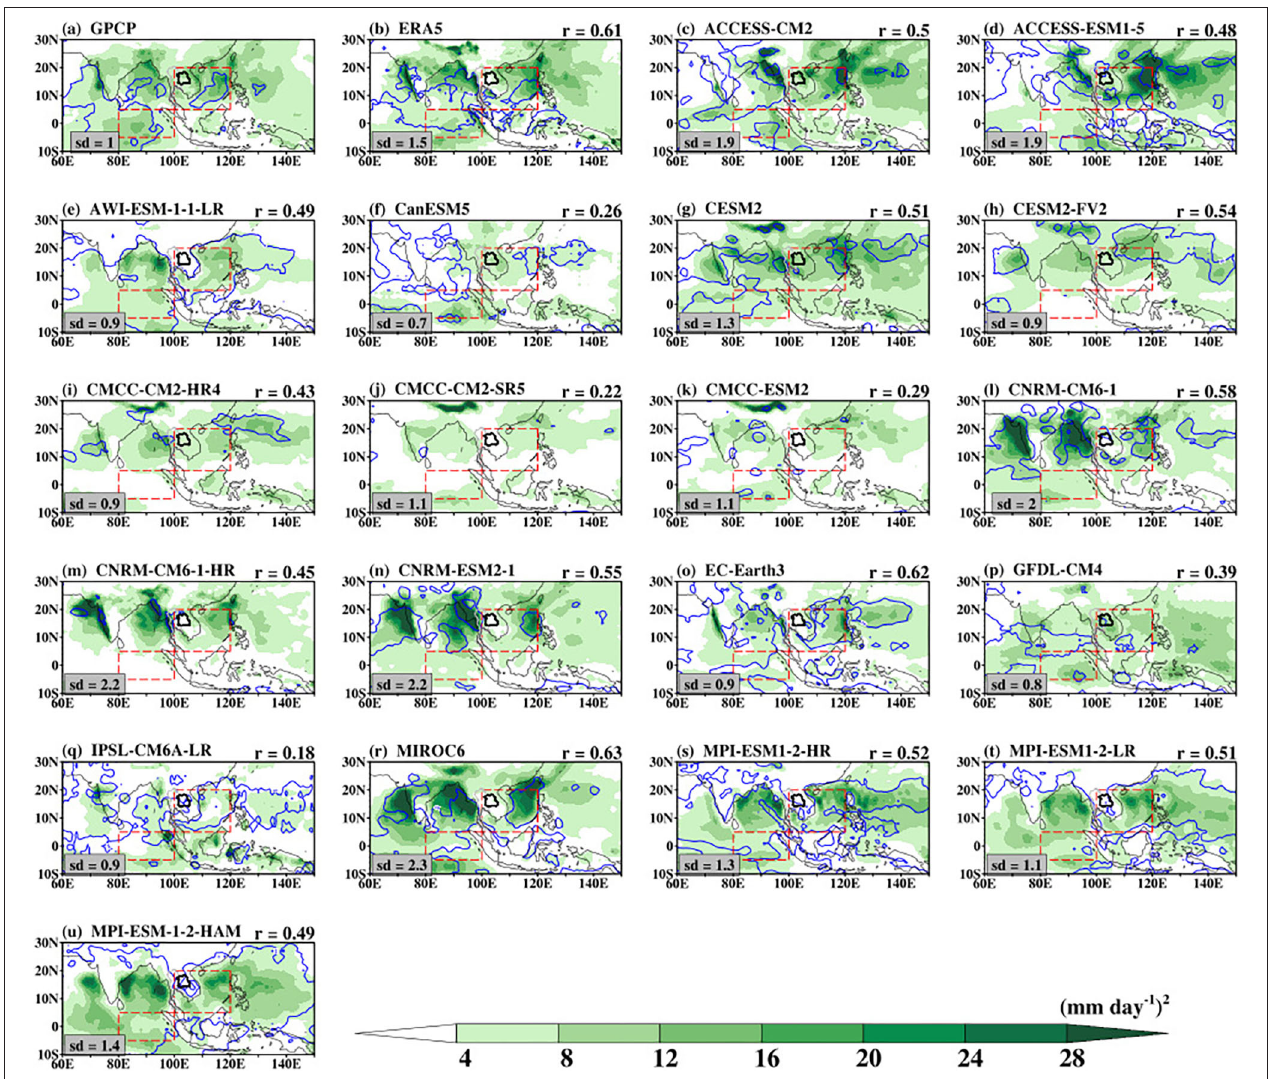
FIGURE 1 | Variance of 30–60-day bandpass-filtered intraseasonal rainfall anomalies during the boreal summer (May–October) obtained from observations and CMIP6 models for the period 1997–2014. The Spearman correlation (r) of filtered rainfall anomaly on ( b ; ERA5) and ( c–u ; CMIP6 models) is obtained against (a) GPCP as the reference. The standard deviation of rainfall normalized by the GPCP standard deviation is shown at the bottom left of the plot. The blue contours represent the ratio of the 30–60-day bandpass-filtered intraseasonal rainfall variance to the total rainfall multiply by 100 (%). Only the 10% isoline of the rainfall variability is shown here. The dotted red boxes indicate the equatorial Indian Ocean and the Southeast Asia